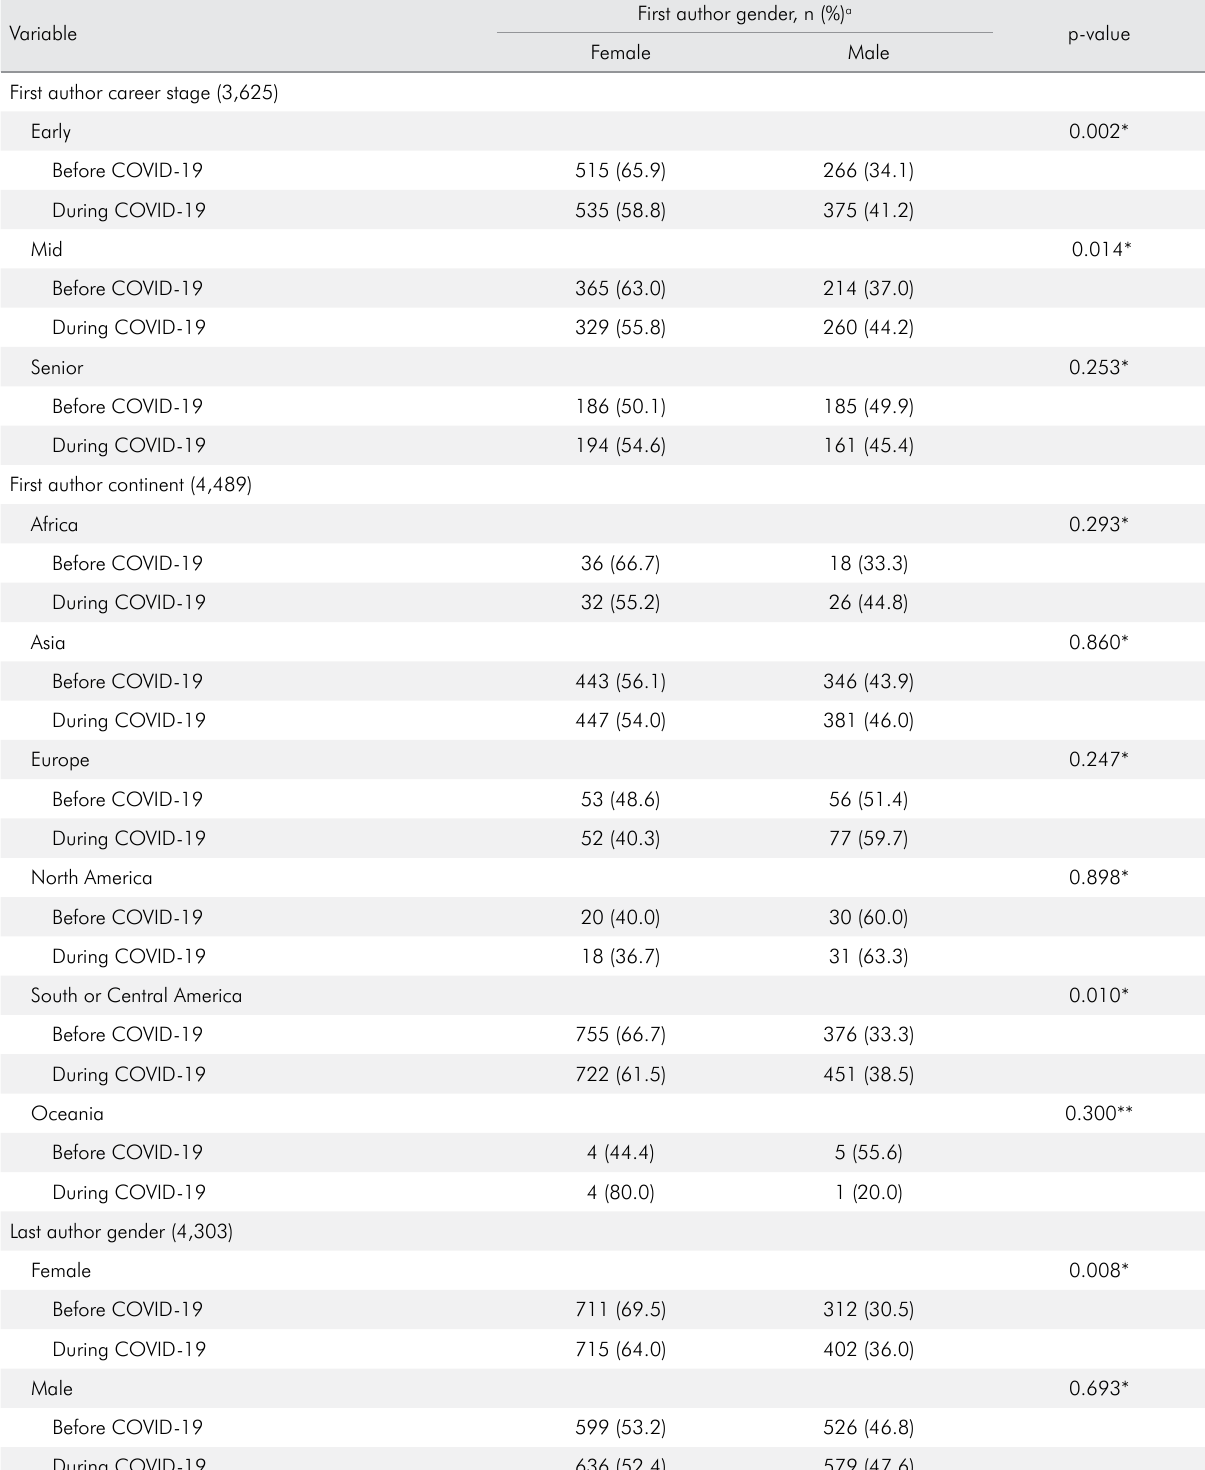
Table 2. Stratified analysis by covariates between the period of submission and gender of the first author, n = 4,726.